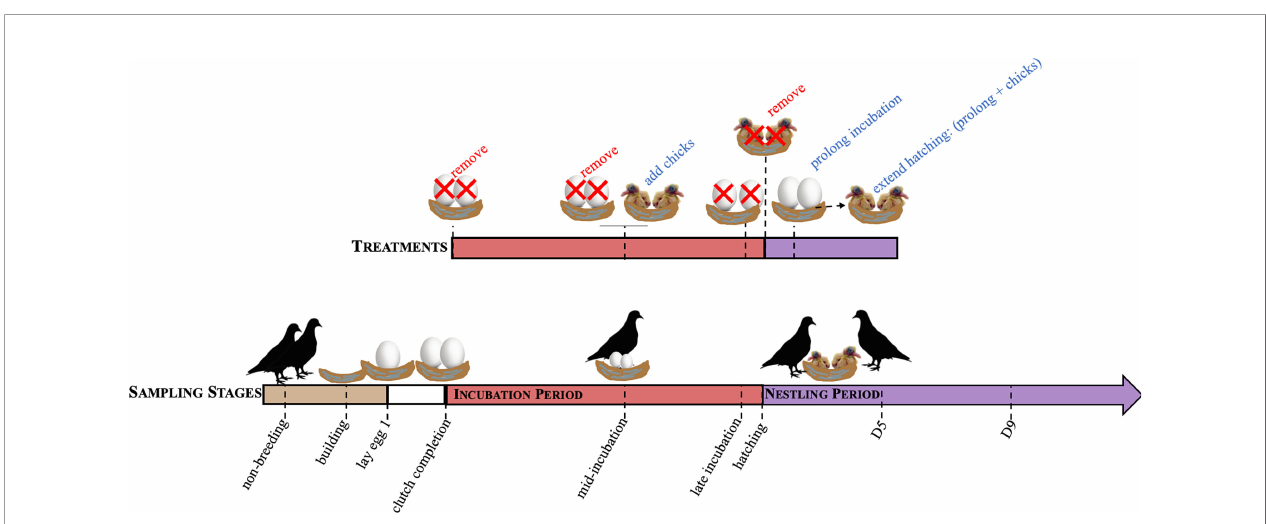
FIGURE 1 | A schematic of the sampling time points to characterize hormones over reproduction (sampling stages) and their paired treatments. Sampling time points included, non-breeding, nest building, laying, clutch completion, mid-incubation (incubation d9), late incubation (incubation d17), hatch, nestling d5 (D5), and nestling d9 (D9). Concordant treatment groups include removing eggs at clutch completion, mid-incubation, and late incubation, and chicks at hatching to simulate nest loss. Adding chicks at mid-incubation decreased the length of the incubation period and incubation period was prolonged by 3 days (to d21) or hatching extended by adding chicks following prolongation.